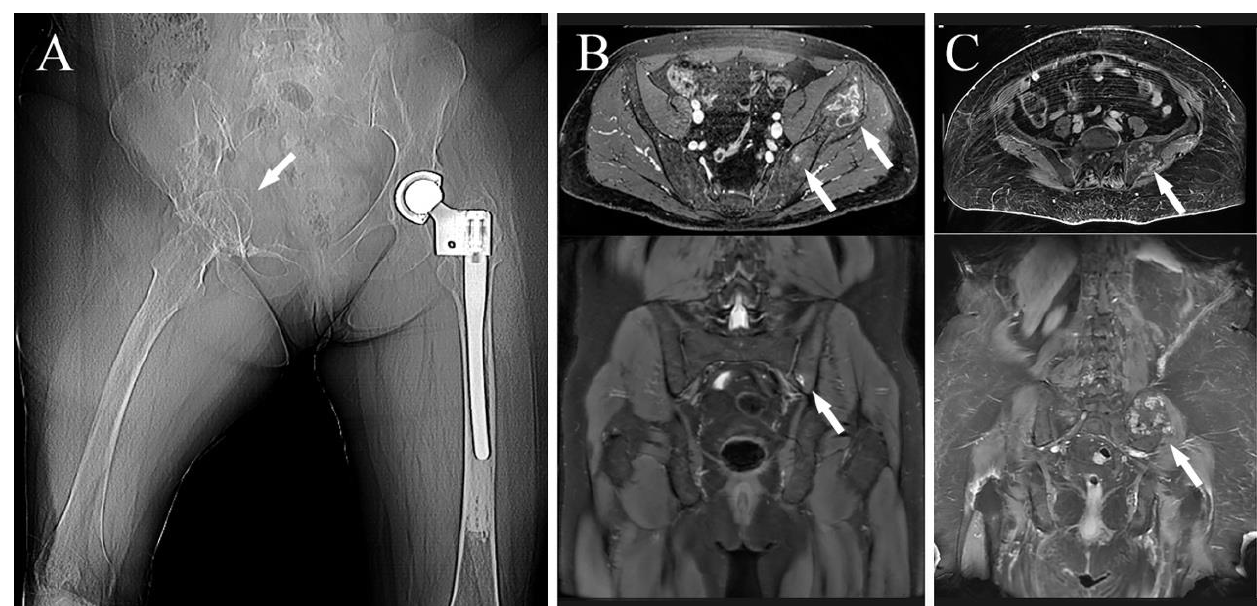
Figure 1. ( A ) Preoperative X-ray showing a right hip fixed in flection in a patient affected by metastatic hemangioendothelioma (white arrow), two years before she underwent left proximal femur replacement for pathological fracture (case 6); ( B ) preoperative MRI of a patient affected by Ewing’s sarcoma of the left hip involving the sacrum-iliac joint as well (white arrows) (case 7); ( C ) preoperative MRI showing a patient affected by a G2-chondrosarcoma of the left sacrum-iliac joint (white arrows) (case 2).